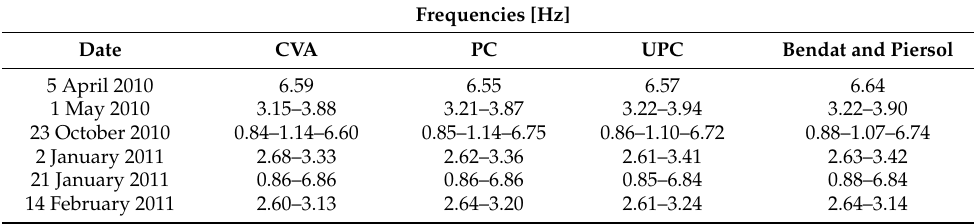
Table 5. Identified frequencies in the east-west direction for the parametric and nonparametric methods.